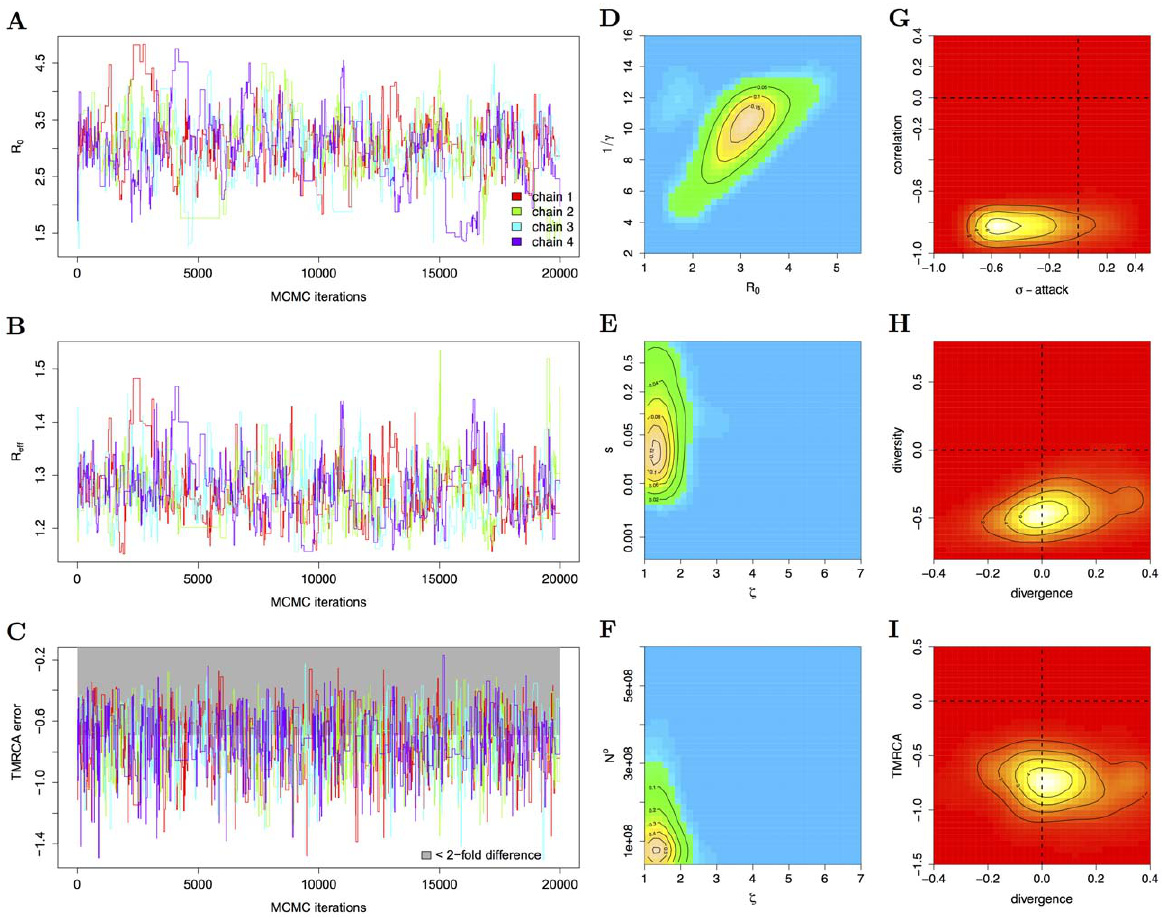
Figure 3. Phylodynamic inference and goodness-of-fit analysis of the spatial SEIRS model. (A–C) MCMC trajectories of the estimated R 0 , the calculated R eff , and the TMRCA summary error of four chains that were started at overdispersed starting values (see Methods). Samples before iteration 1000 were discarded. (D–F) Two-dimensional histograms of parts of the ABC fit, illustrating the correlations between the estimated parameter pairs ( R 0 , 1 = c ), ( s , f ) and ( N (cid:2) , f ). Throughout, histograms were computed from all samples across the four chains after burn-in. Color codings are separate for each subplot, with respective density values indicated in the contours. (G–I) Two-dimensional histograms of parts of the joint density of summary errors, illustrating goodness-of-fit with respect to the correlation and interannual variability of the case report data, as well as the divergence , diversity and the TMRCA ’s of the HA phylogeny.